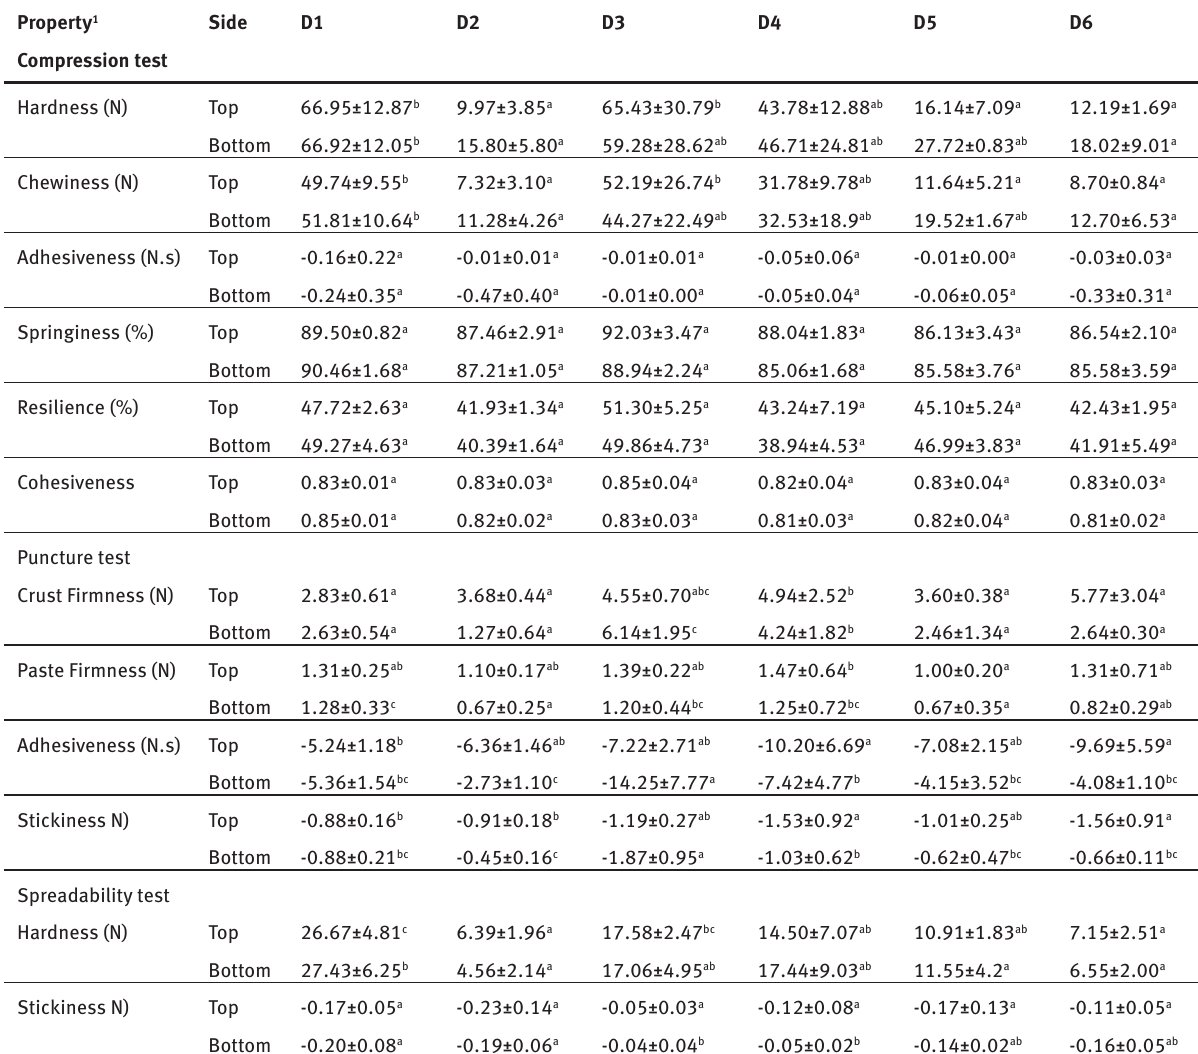
Table 2: Textural properties on top and bottom faces of the cheeses in June (the last moment of evaluation), obtained by the different tests Property